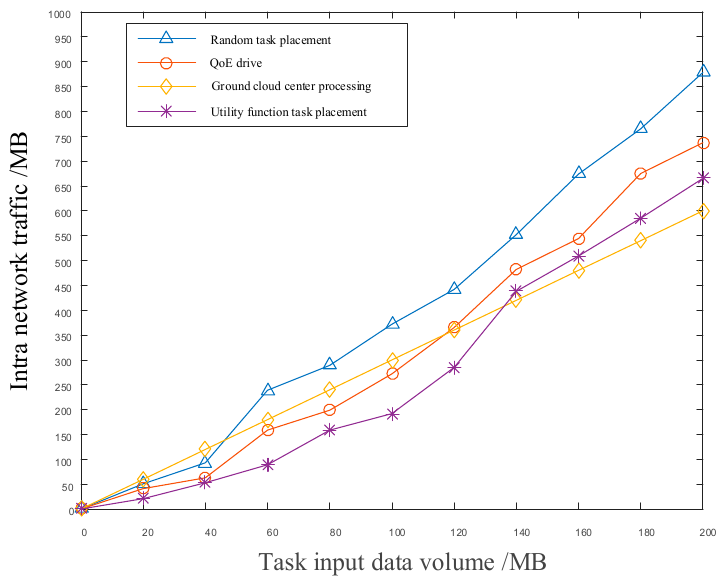
Figure 9. The comparison of network traffic with the amount of task input data.